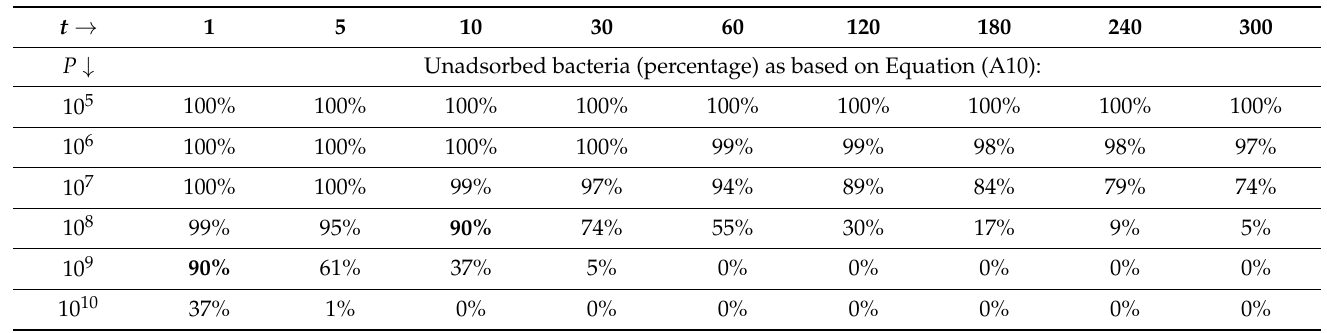
Table A3. Percentage of bacteria remaining unadsorbed as functions of phage titers ( P ) and